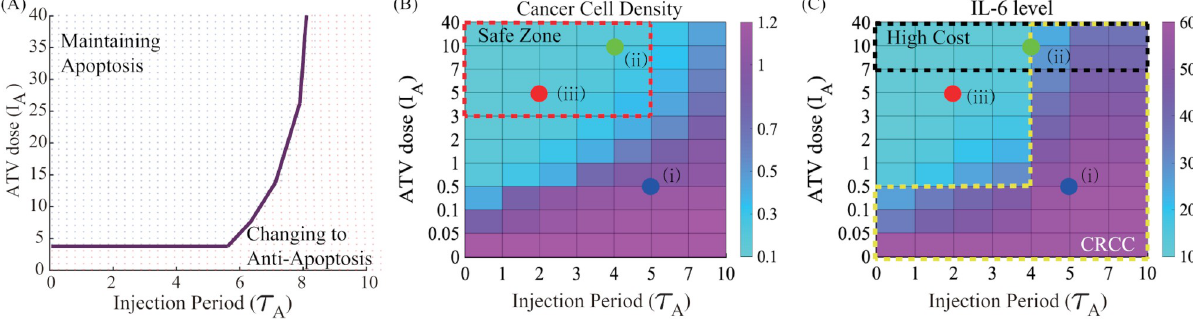
Fig 10. Therapeutic effect of ATV infusion in the combination (TZB+ATV) therapy. (A) Persistence of apoptosis at later times in the τ A − I A plane. (B,C) Cancer populations (B) and IL-6 levels in response to the combination therapy with various doses ( I injection periods ( τ A = 0, 1, 2, 3, 4, 5, 7, 10) of ATV infusion at final time ( t = 40 days ). The best schedule ((iii); marked in red circle) can be obtained by avoiding CRCC and minimizing costs (minimizing doses and maximizing infusion periods) while keeping the low tumor